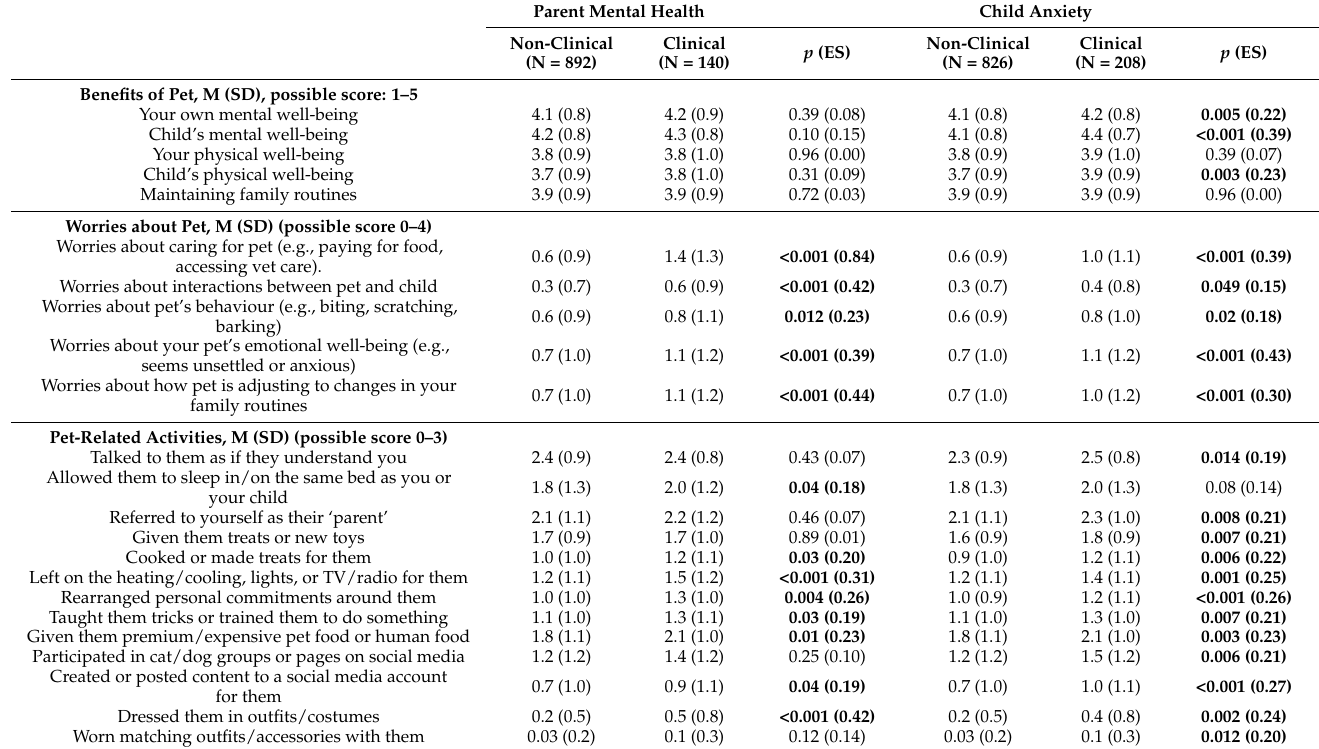
Table 4. Item-level descriptives for perceived pet benefits, worries about pet, and pet-related activities separately for parent and child non-clinical and clinical mental health groups (N = 1034).